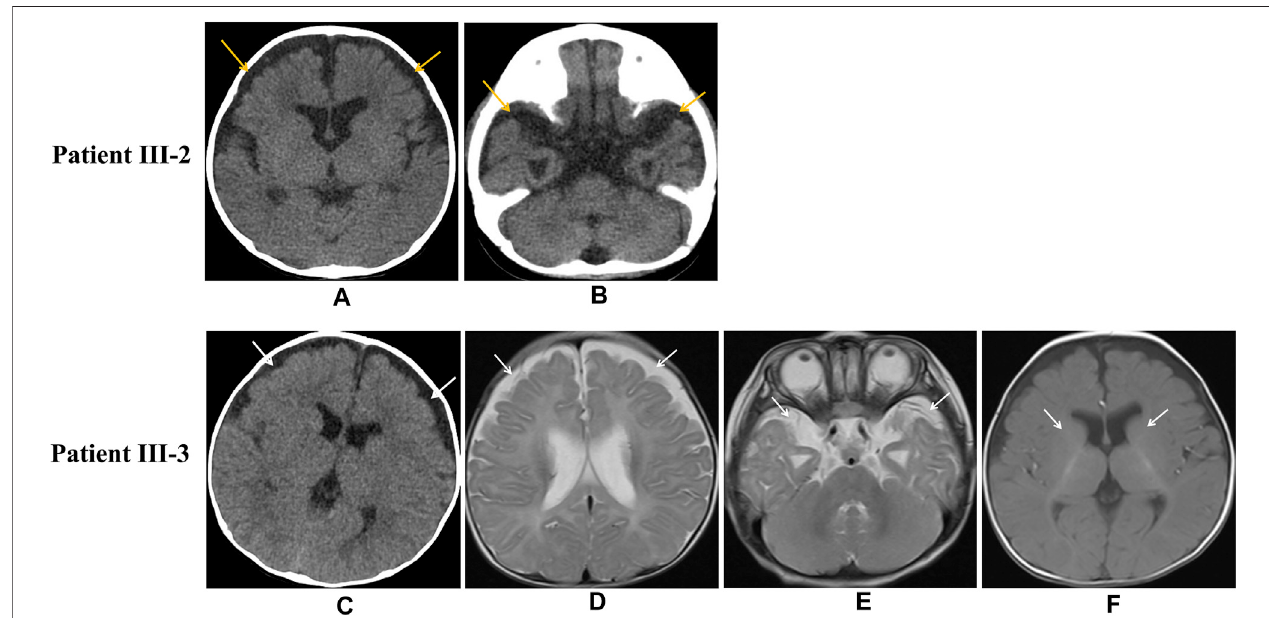
FIGURE 2 | Imaging of patient III-2 and patient III-3. Unenhanced head CT indicates widening of the bifrontal frontotemporal subarachnoid space in patient III-2 ( Figures 2A,B ) Unenhanced head CT of patient III-3 shows bifrontal widening frontotemporal of the subarachnoid space ( Figure 2C ), and axial MRI shows bifrontal widening frontotemporal of the subarachnoid space ( Figures 2D,E ) and delayed myelination of white matter ( Figure 2F